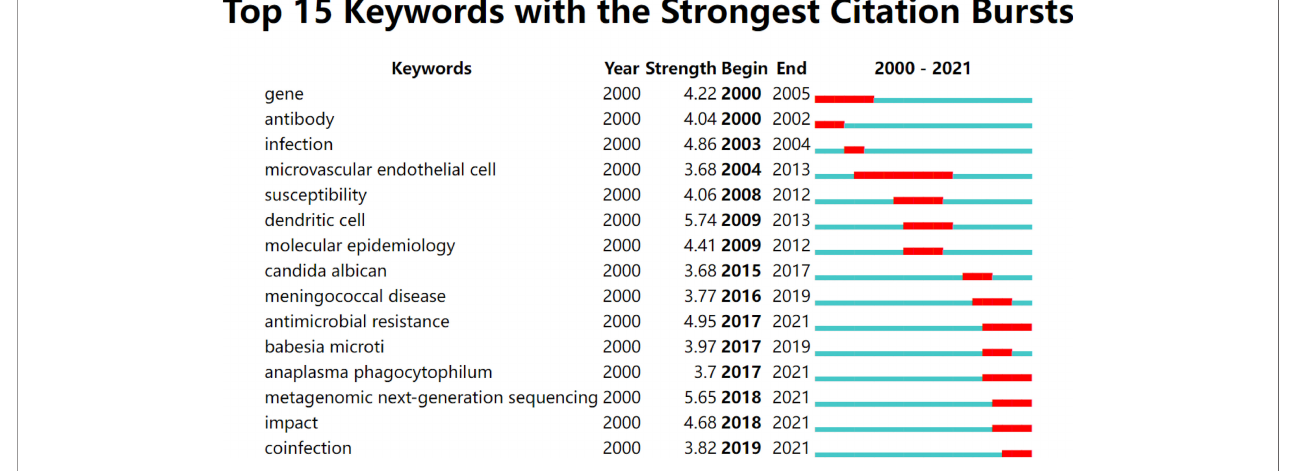
FIGURE 6 | Top 15 keywords with burst impact (sorted by the beginning year of